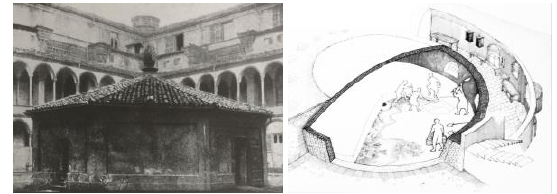
Fig. 3. Ospedale Maggiore’s ice house before destruction (left); and a sketch of a typical ice house with double-walled structure (right).